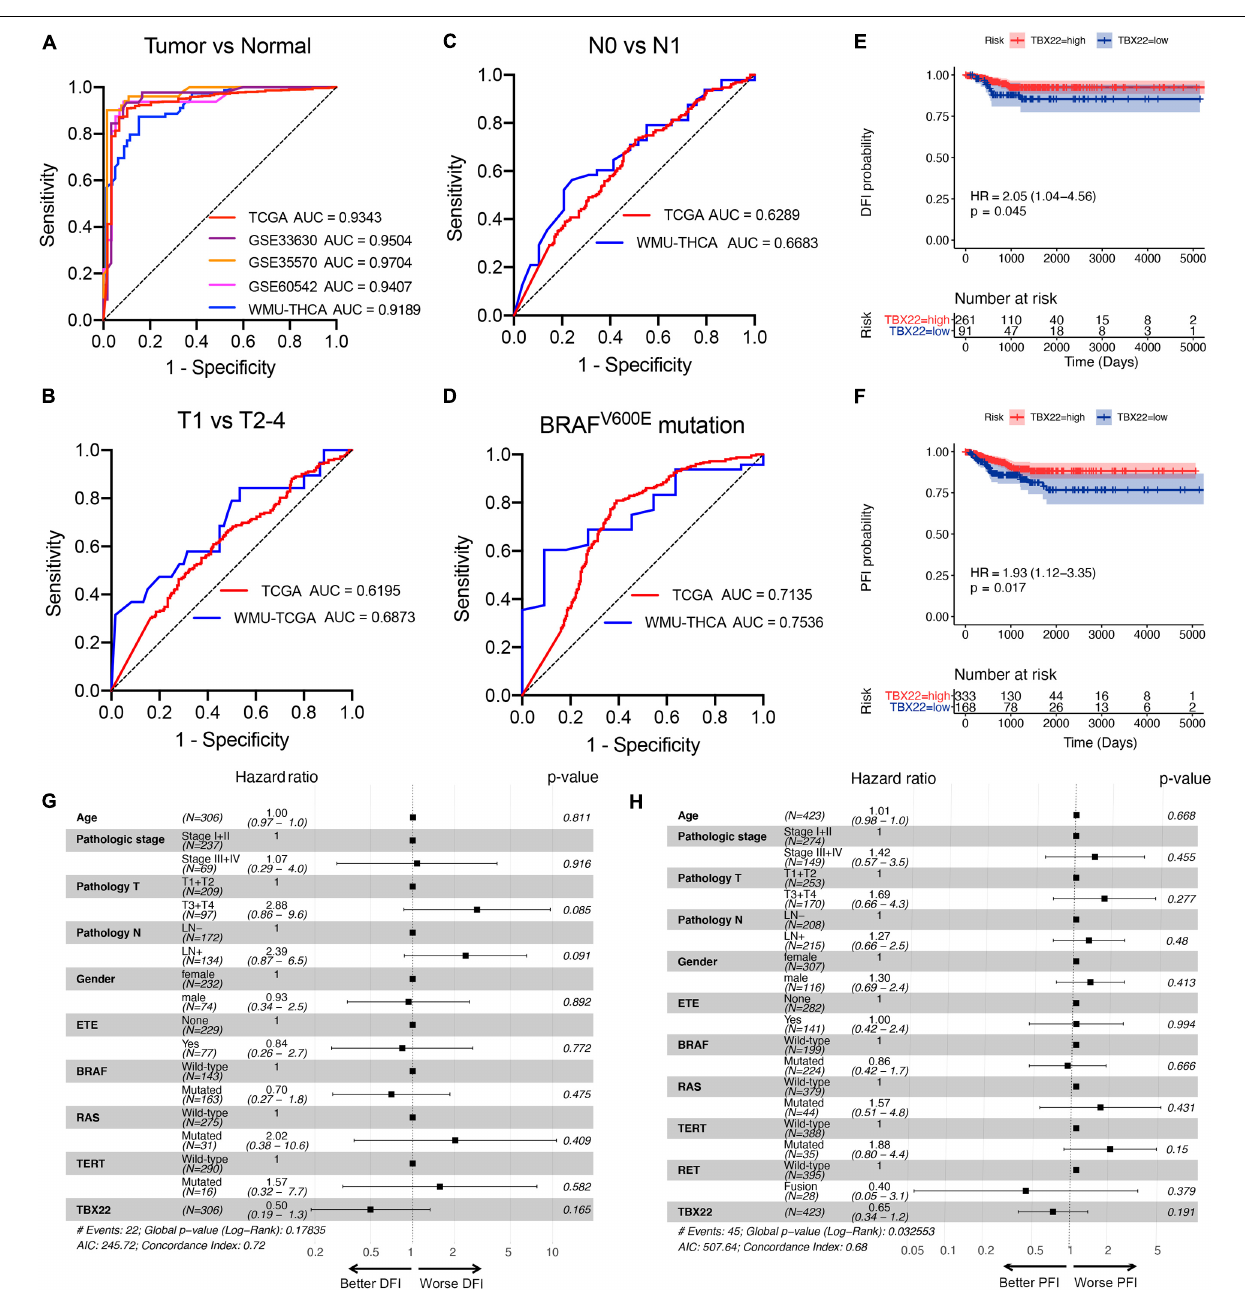
FIGURE 4 | TBX22 is a potential predictive biomarker in PTC. (A) ROC curves showed the diagnostic values of TBX22 in public PTC datasets and our local cohort. (B–D) ROC curve analysis shows predictive efficiency of TBX22 in (B) T stage, (C) LNM status, and (D) BRAF V 600 E status. (E,F) Comparison of Kaplan–Meier curves of patients with high and low TBX22 expression along with log-rank test p -values and hazard ratios (HR) with confidence intervals is shown for (E) DFI and (F) PFI in the TCGA cohort. DFI, disease-free interval. PFI, progression-free interval. (G,H) Multivariable Cox regression analyses of DFI (G) and PFI (H) in PTC